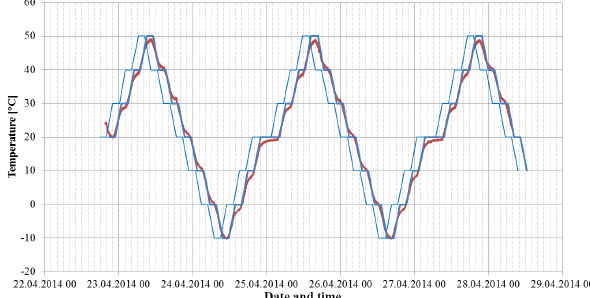
Figure 1. Temperature exposed to the cylinders in the climate cham- ber. Every 2h, the temperature changed by 10 ◦ C. The actual tem- perature (red line) follows the set temperature (light blue) with a delay of 2.75h (the bold blue line accounts for the time